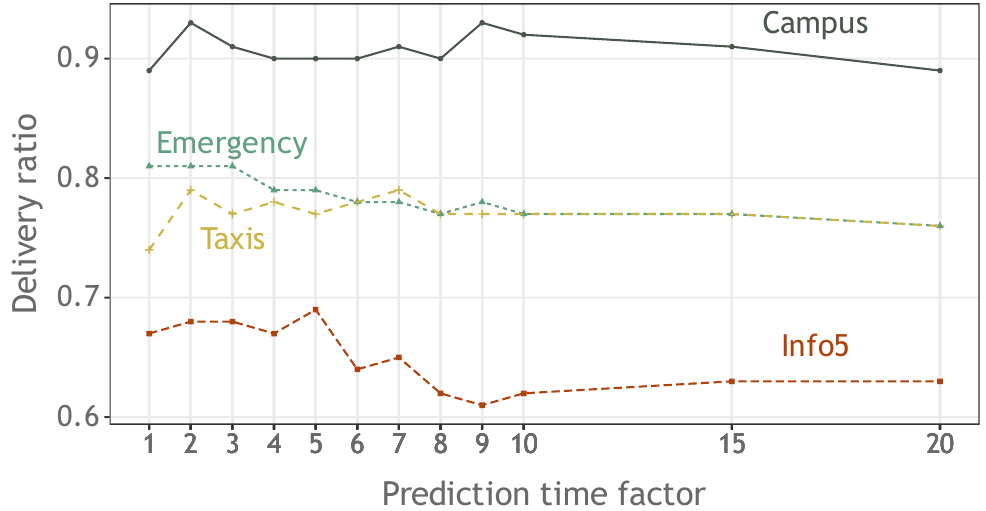
Figure 16. Delivery ratio depending on the prediction time factor.